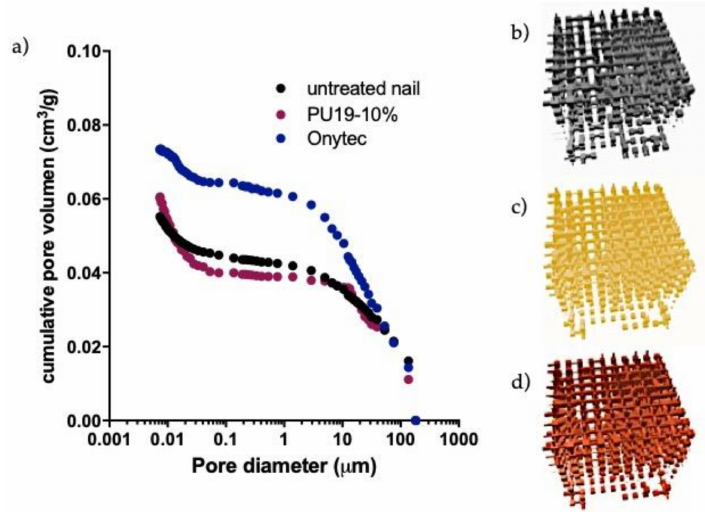
Figure 5. Cumulative curves of porosity obtained by MIP for treated and untreated for nail ( a ) and PoreXpert models of the microstructure of ( b ) untreated nail, ( c ) Ony-Tec ® treated nails and ( d ) PU19-10% treated nails. Cubes represent the pores and cylinders the connection between pores.